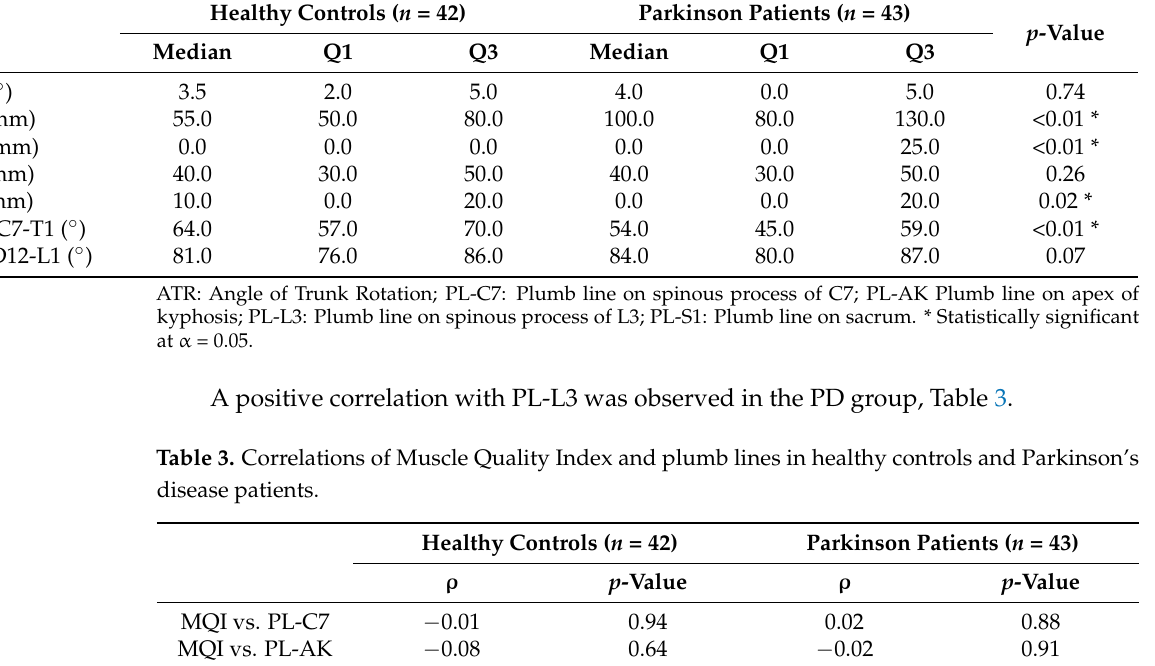
Table 2. Parameters of spinal alignment in healthy controls and Parkinson’s disease patients. Healthy Controls ( n = 42)